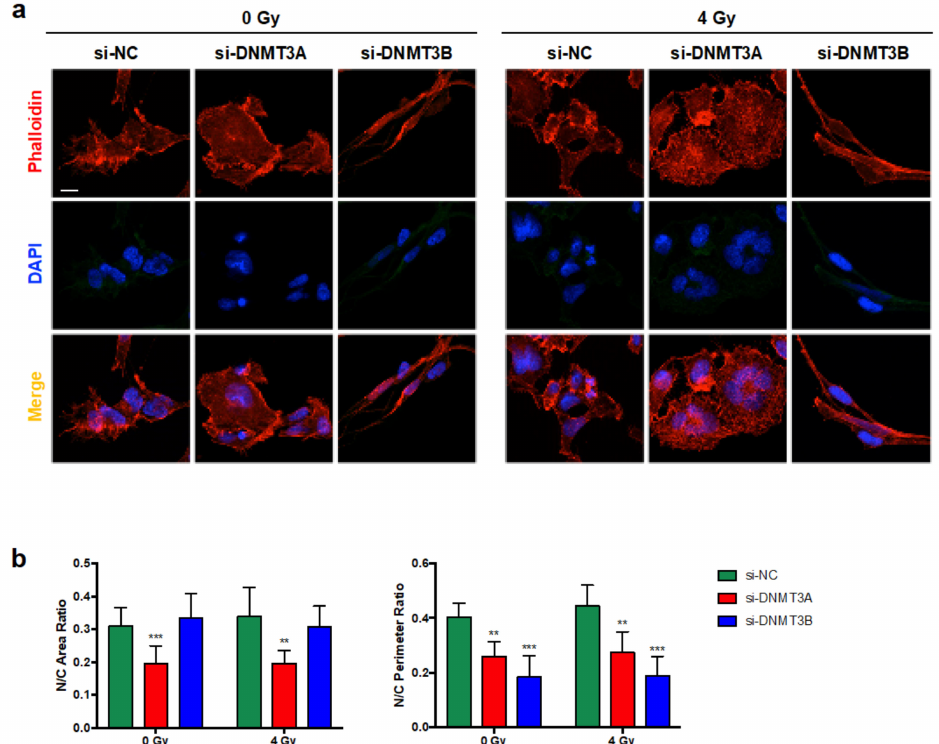
Figure 7. Morphological changes induced by DNMT3A and DNMT3B silencing and radiation treatment in RD cells. ( a ) IF assays showing the expression of Phalloidin in si-DNMT3A and si- DNMT3B depleted RD cells, also exposed or not to IR. DAPI was used for nuclear staining. Images were acquired by using ApoTome microscope at 40 × magnification. Scale bar 50 µ m. ( b ) Histograms represent the mean value ± SD of nucleus (N)/cytoplasm (C) area (left panel) or perimeter (right panel) ratio calculated by using ImageJ software. Area and perimeter of N and C were measured for each cell in four random merged Phalloidin/DAPI images for the specific silencing (**, p < 0.01; ***, p < 0.001 vs. si-NC/0 Gy). In multinucleate cells, the nuclear area or perimeter was calculated as the sum of each